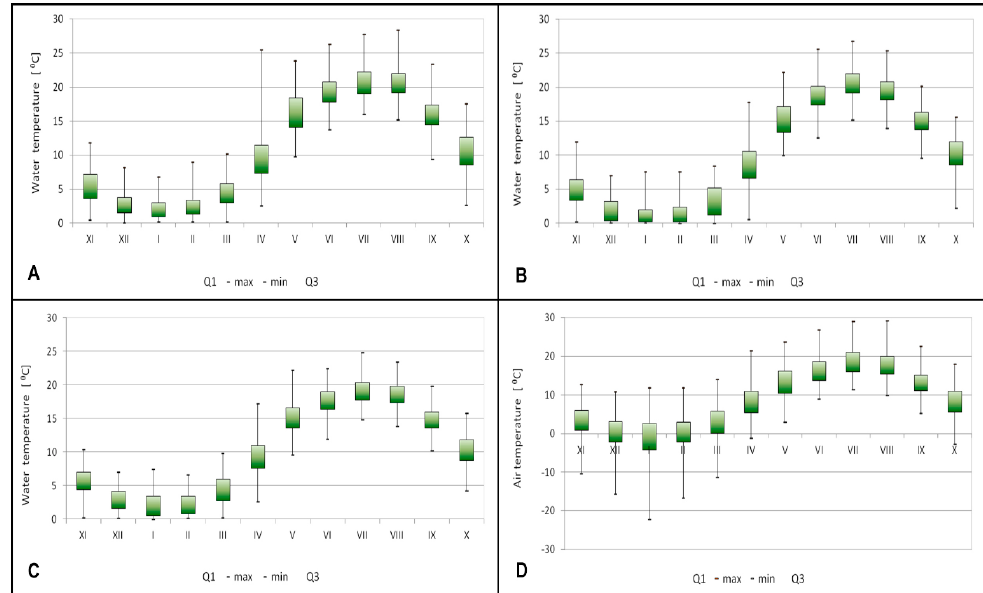
Figure 6. The variability range (min.–max.) for monthly water temperature series of the Note ć in Pako ść ( A ), Uj ś cie ( B ) and Nowe Drezdenko ( C ), and air temperature in Pi ł a ( D ) (1987–2013). At the Uj ś cie station, meanwhile, the period from December to March is characterised by clearly positively skewed river water temperature distributions. For the lower stretch of the Note ć (Nowe Drezdenko), the water temperature distribution for January, February and March is characterised by not completely correct (positive) skewness (Figure 6). For the Drawa in Drawiny and the Gwda in Pi ł a (except for distributions for December, January, February and March), the water temperature distributions in individual months are close to normal, or at least relatively symmetrical, and this shows that during the entire analysed period under study, monthly temperatures were relatively stable. Monthly distributions of air temperatures in Pi ł a are also approximately normal. Only the distributions for December, January and February are slightly negatively skewed (Figure 6). For measurement series of the water temperature of the Note ć and its tributaries, and also of air temperature (Pi ł a), the augmented Dickey-Fuller test ADF [39] showed that the daily temperature series are stationary (Table 2). Table 2. Results of an augmented Dickey-Fuller test from a daily water “tw” and air temperature “ta” measurement series (1987–2013).